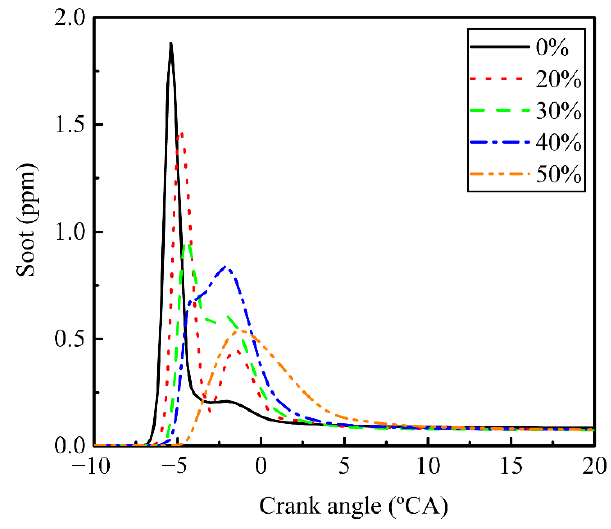
Figure 17. Soot formation in the active cylinder under the CDAc + EGR mode with the EGR rate from 0% to 50% at an engine speed of 450 rpm and an engine load of 1000 N ∙ m (the calculated results were obtained from 3D simulation of ESE DIESEL).